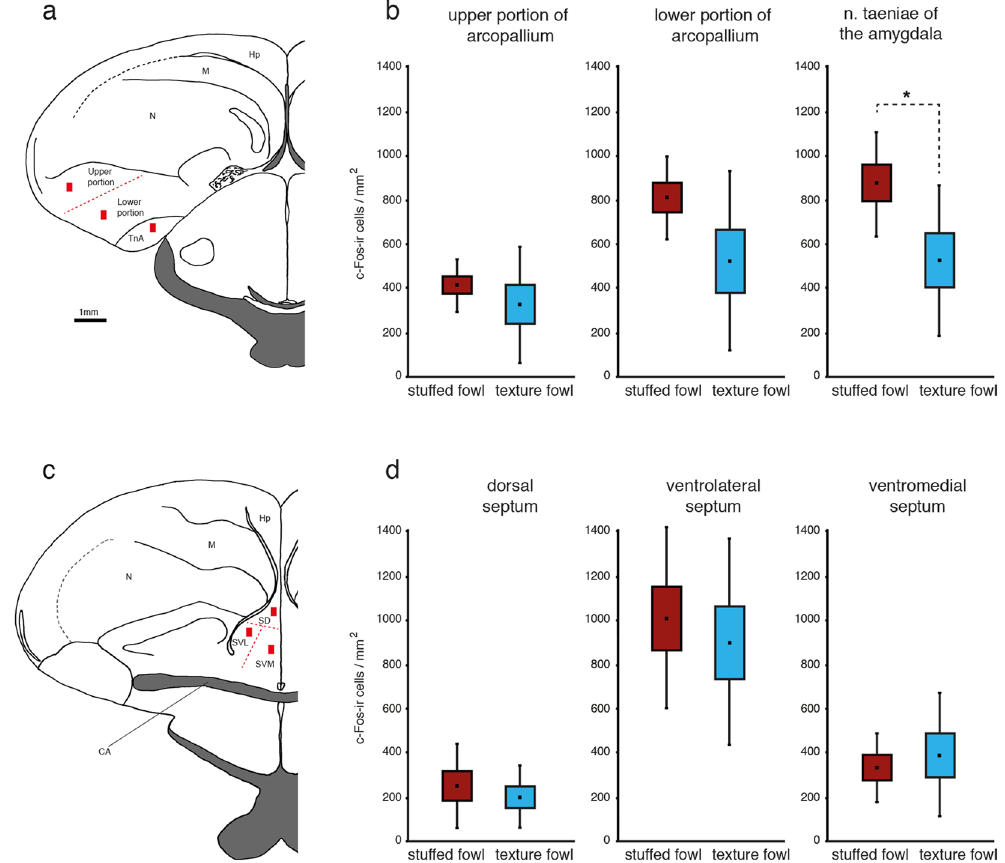
Figure 3. Results of the brain analysis. ( a ) Schematic view of a coronal section showing a typical placement of the cell count zone (red rectangles) within the upper portion of the arcopallium; lower portion of the arcopallium and nucleus taeniae of the amygdala (TnA). ( b ) Significantly higher number of c-Fos-ir neurons is present in the TnA of the experimental chicks compared to controls (n = 8 in each condition). A similar trend is also visible in the lower portion of the arcopallium. ( c ) Typical placement of the cell count zone within the septum with its portioning into dorsal (SD), ventrolateral (SVL) and ventromedial (SVM) subdivisions (red lines). ( d ) The densities of c-Fos-ir cells in any of the septal subregions were not different between the two groups. Graph-plot: mean (black square), standard error of the mean (box) and standard deviation (whisker) ( * P < 0.05). Drawings were adapted from the atlas of Kuenzel & Masson (1988). Hp = hippocampus, M = mesopallium, N = nidopallium, Str = striatum, CA = anterior